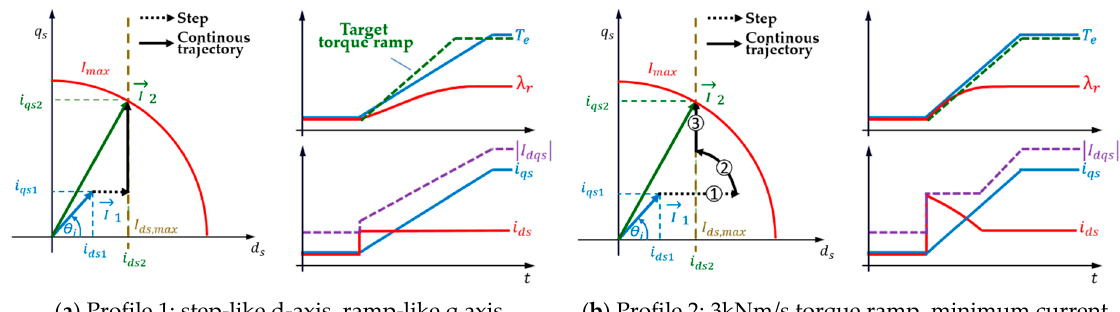
Figure 17. Remagnetization ( a ) using the rated d-axis current and ( b ) target torque gradient. Left: Current trajectories in the d - q plane; right: torque, rotor flux, and current trajectories vs. time.